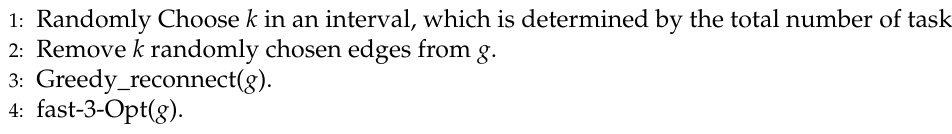
Algorithm 6 PTAMG-mutation ( g